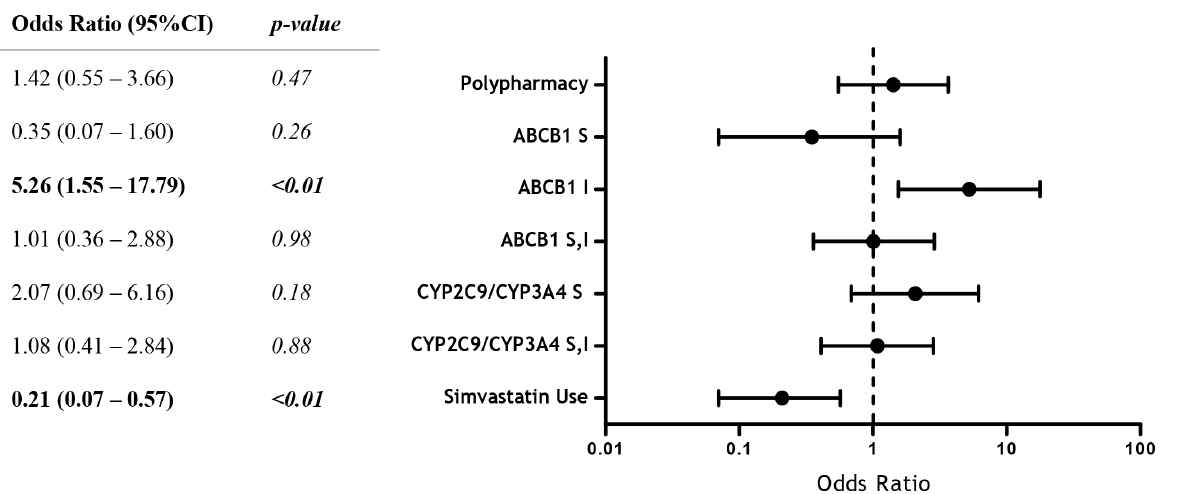
FIGURE 1 - Pharmacotherapy factors associated with statin-related adverse muscular events in dyslipidemic patients. ABCB1: P-glycoprotein; S: Substrate; I: Inhibitor; CI: confidence interval.